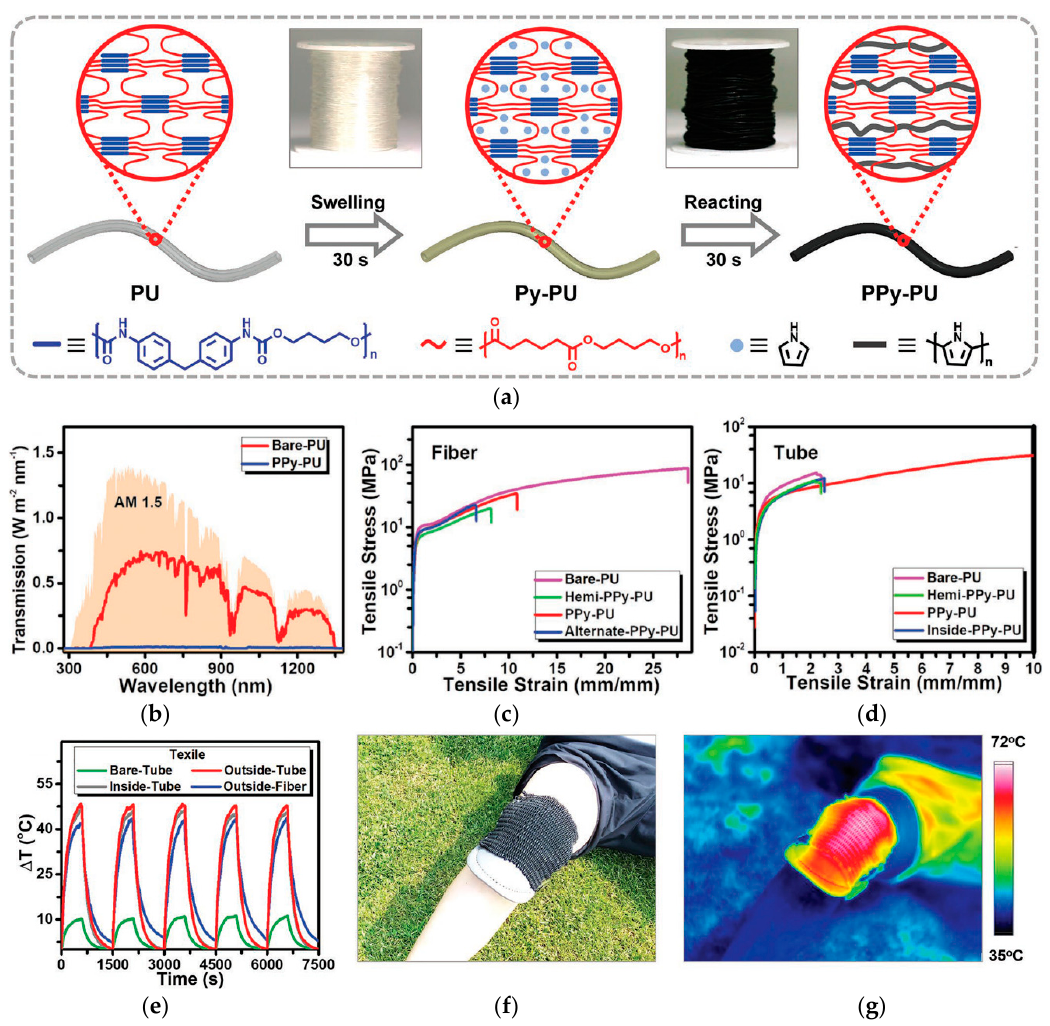
Figure 5. ( a ) Schematic illustration of the preparation process of PPy-PU elastomers, ( b ) transmittance power density of the bare-PU and the PPy-PU film, and the AM1.5 solar spectrum plotted as a reference. Tensile strain–stress curves of PU or PPy-PU, ( c ) fibers, ( d ) tubes, ( e ) temperature change of different textiles under cycles of on-off light illumination, ( f ) optical image of a photothermal kneecap for warming a knee joint in natural sunlight, and ( g ) the corresponding infrared image. Reproduced from Ref. [104] with permission. Copyright 2018, John Wiley and Sons.